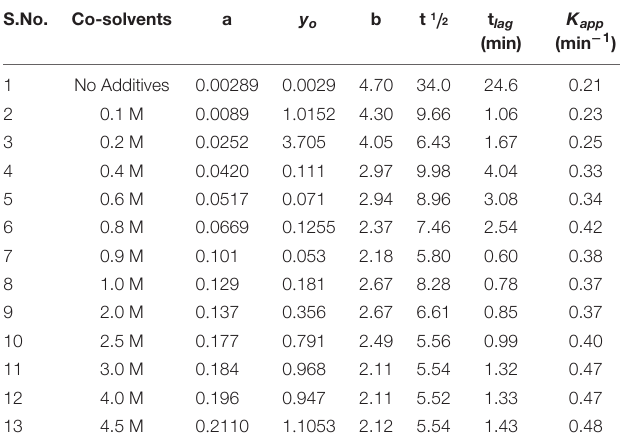
TABLE 3 | Change in kinetic parameters associated with aggregation of BSA in the presence of monosodium glutamate at varying concentrations from 0.1 to 4.5 M at temperature 70 ◦